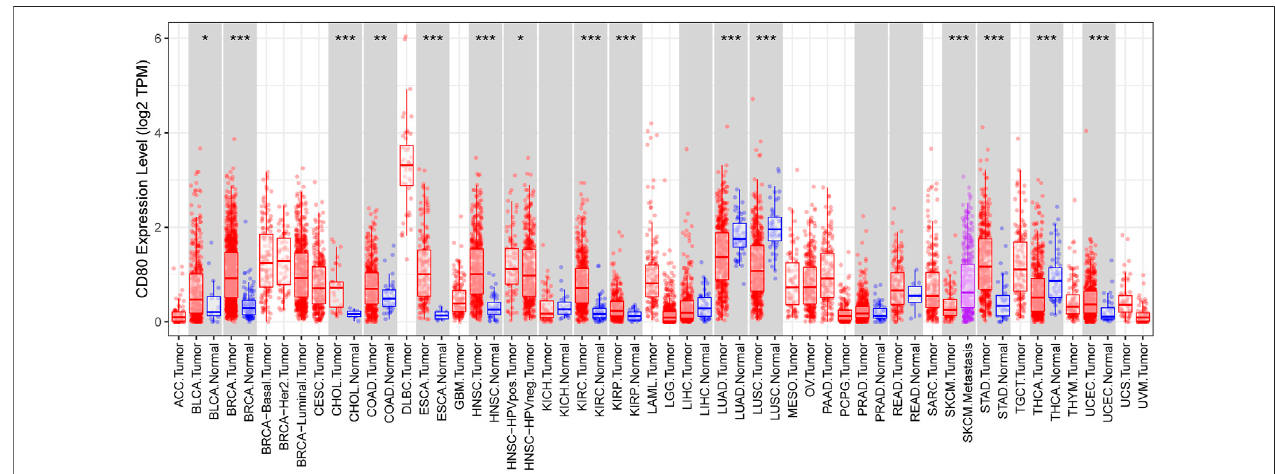
FIGURE 1 | CD80 expression status in pan-cancer. CD80 expression levels in all tumors and adjacent normal tissues across TCGA (* p < 0.05, ** p < 0.01, and *** p <